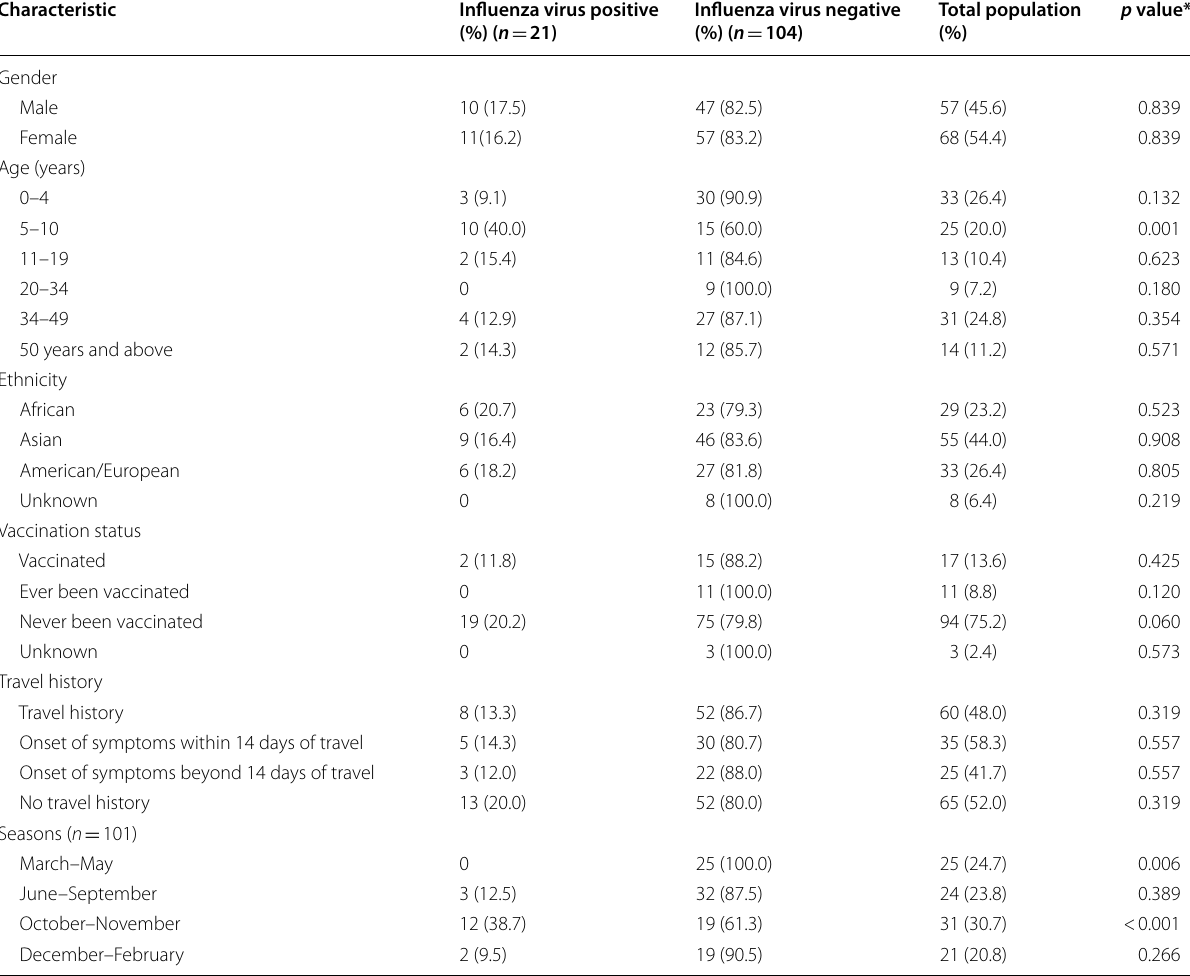
* Seasonal distribution of ILI and influenza cases was based on seasonal weather changes in Nairobi